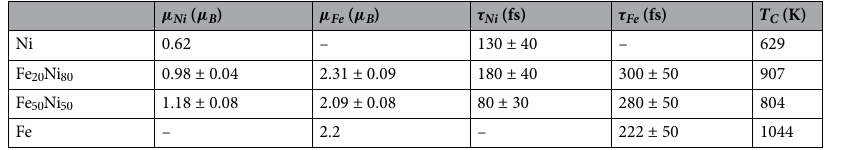
Table 1. Atomic magnetic moment, demagnetization time and Curie temperatures for Ni, Fe, Fe 20 Ni 80 and Fe 50 Ni 50 . Atomic magnetic moments are deduced from XMCD measurements at room temperature 16 . All demagnetization times, deduced from time resolved XMCD measurements at room temperature, are adapted from 14 . The Curie temperature for the pure elements are adapted from 20 and from 14 for the